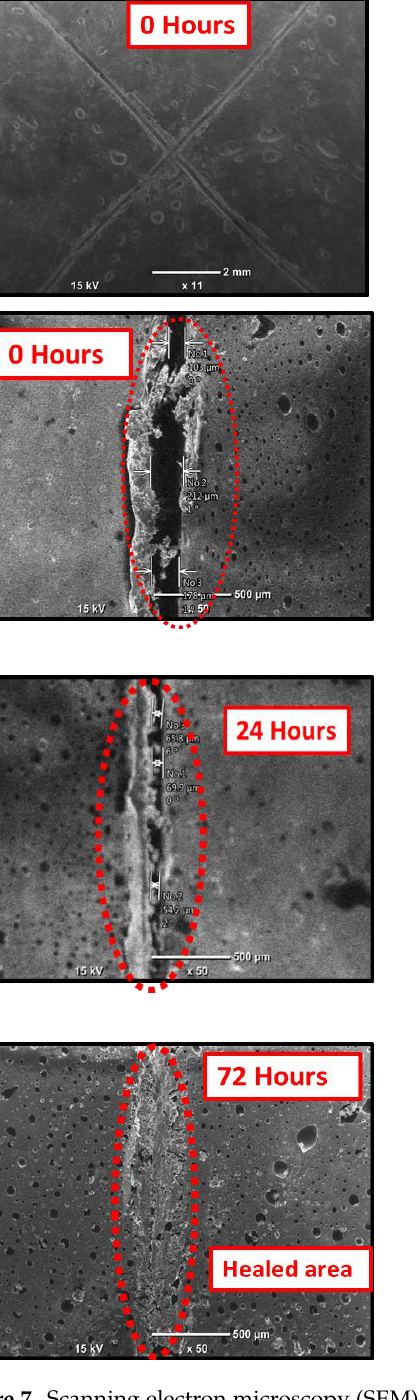
Figure 7. Scanning electron microscopy (SEM) images of the scratched reinforced CeO 2 /DDA (left) and CeO 2 /NMTU (right) epoxy coating at different time intervals (0, 24 and 72 h).